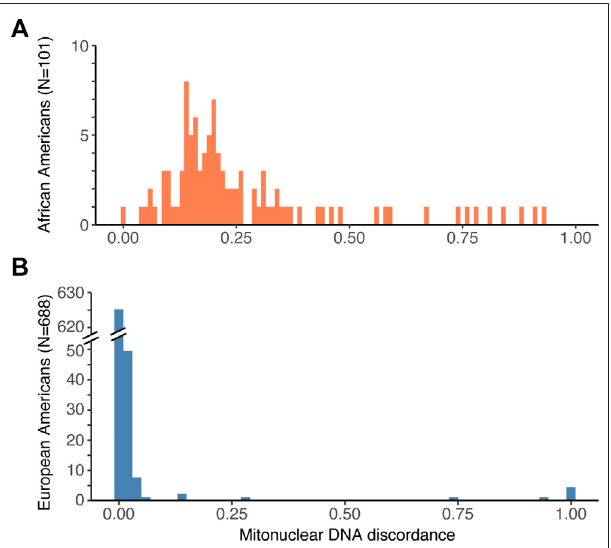
FIGURE 1 | Histogram of mitonuclear DNA discordance values for (A) African Americans, and (B) European Americans. Note that the range of the Y axisismuchsmallerin (A) thanin (B) ,whichre fl ectsthesmallersamplesizefor African Americans than for European Americans among the genotyped individuals in the GTEx